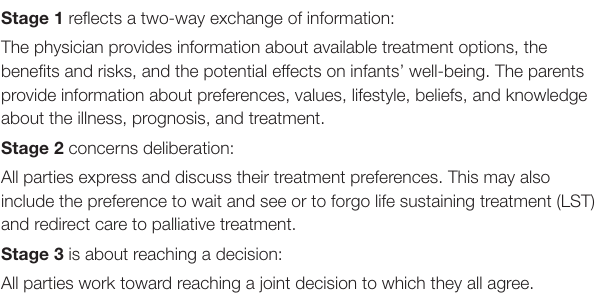
TABLE 1 | Three stages of shared decision-making.